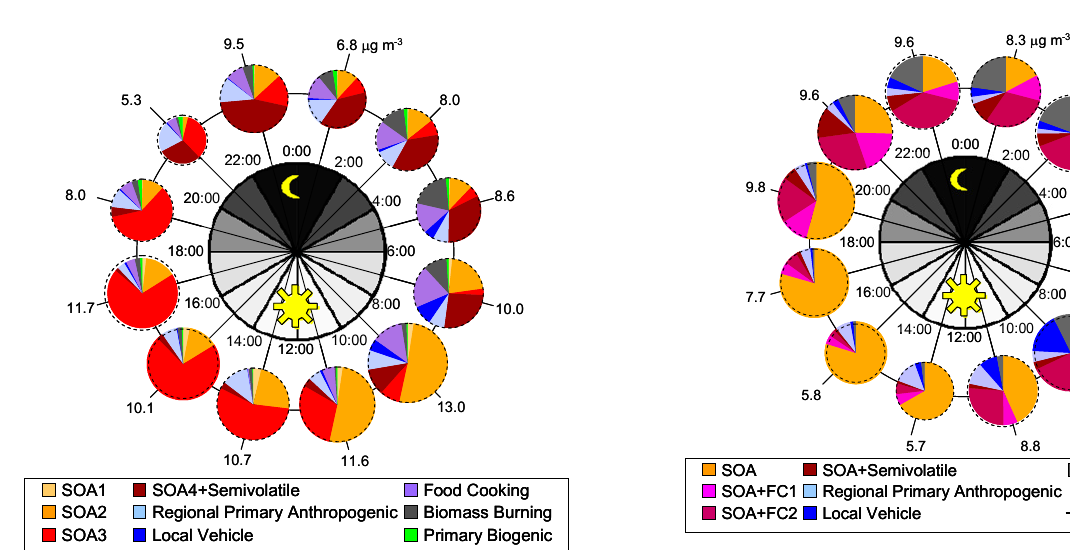
Fig. 15. Average diurnal concentrations of TAG-derived PMF fac- tors over the summer focus period. PM 1 organic aerosol mass con- centrations labeled outside of pie chart ring, and time of day labeled inside of pie chart ring.